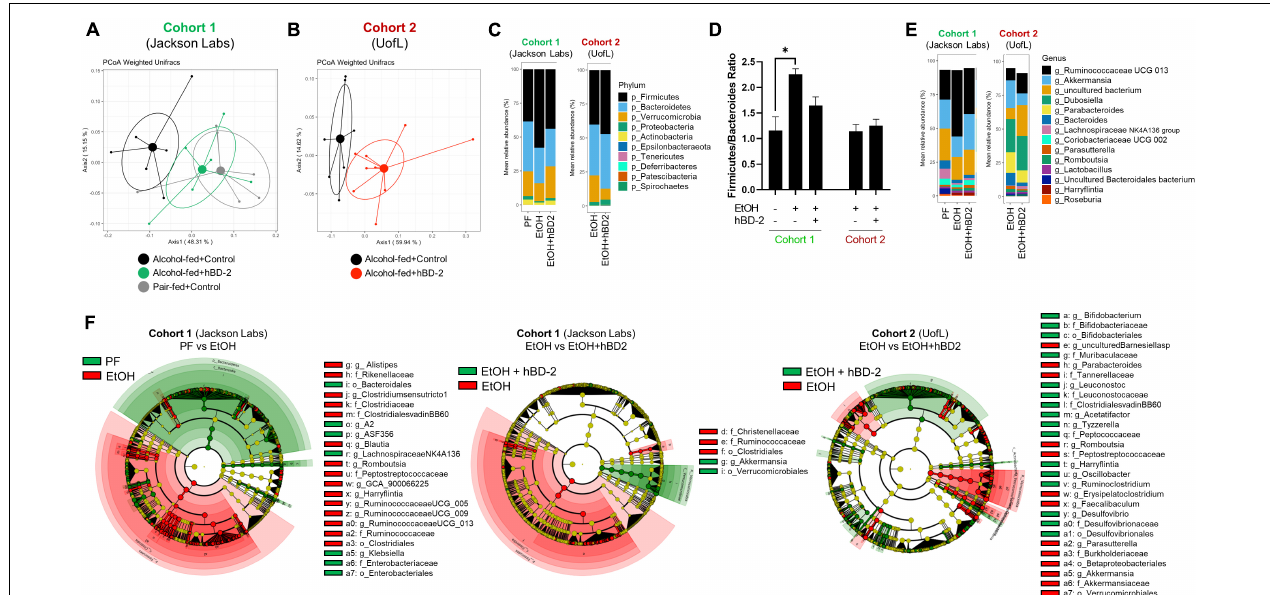
FIGURE 6 | Human beta defensin 2 alters the composition of the gut microbiota. (A,B) Principal coordinate analysis using weighted UniFrac distance at the conclusion of the study for Cohort 1 and 2, respectively. Individual data points are shown as points with indicated group mean and 50% confidence interval. PERMANOVA between EtOH and EtOH + hBD-2 p = 0.037 and p = 0.002 in panels (A,B) , respectively. (C) Phylum-level summary of mean relative bacterial abundance. (D) Firmicutes / Bacteroides ratio. Data are reported as mean ± standard error of the mean. * p < 0.05. (E) Genus-level summary of mean relative bacterial abundance. (F) LEfSE cladograms showing taxonomical groups of bacteria associated PF or EtOH conditions in Cohort 1 (green and red, respectively; left), EtOH or EtOH + hBD-2 conditions in Cohort 1 (green and red, respectively; middle), and EtOH or EtOH + hBD-2 conditions in Cohort 2 (green and red, respectively;